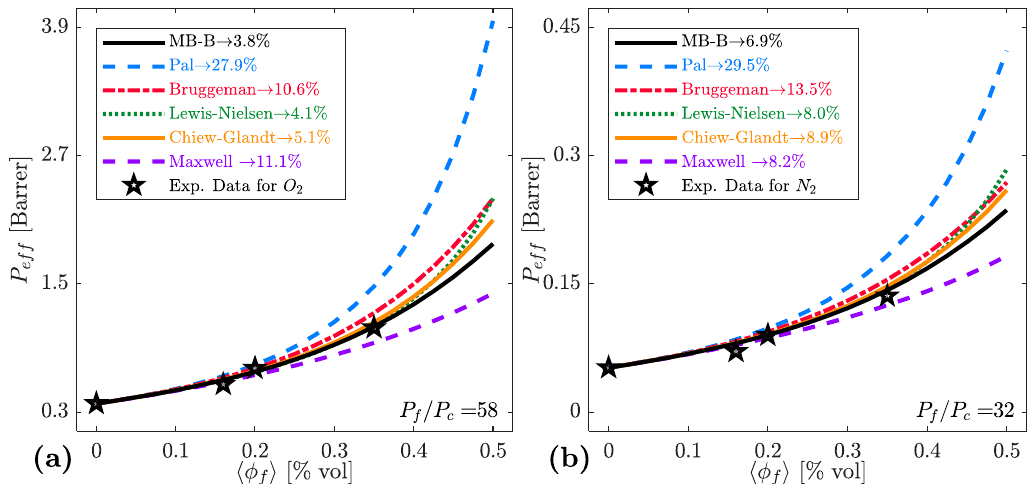
Figure 10. Comparison of the effective permeability profiles based on various EMA models to experimental permeation data in CMS/Ultem 1000 MMMs from [46]: ( a ) O 2 and ( b ) N 2 . While Monsalve-Bravo and Bhatia [153] studied the effect of isotherm nonlinearity for one of